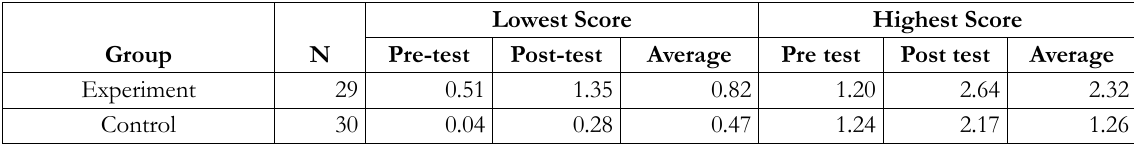
Table 5. Results of descriptive statistical calculations: lowest, highest, and average scores average in both classes Based on Table 5, it can be seen that there are differences in the pre-test and post-test abilities in both the experimental and control classes. In the experimental class, the lowest pre-test PSS score was 0.51, and the highest was 1.20, while the lowest post-test PSS score was 1.35, and the highest was 2.64. The average PSS score differs between the pre-test and the post-test: the pre-test average is 0.82, while the posttest average is 2.32. In the control class, the lowest PSS score on the pre-test is 0.04, and the highest is 1.24, while the lowest PSS score on in the post-test is 0.28 and the highest is 2.17. In addition, there